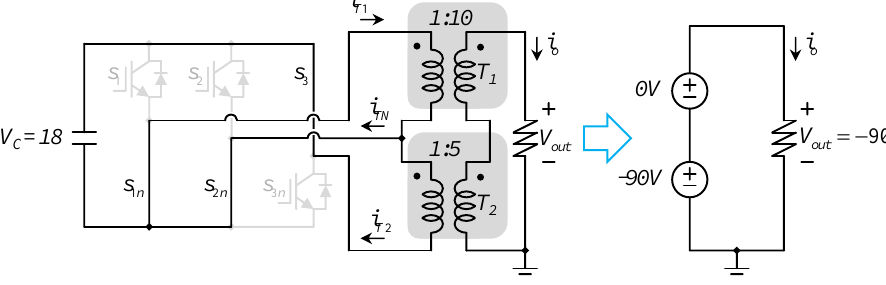
Figure 6. Equivalent circuit when s 1 = 0, s 2 = 0, and s 3 = 1 ( s 1 n = 1, s 2 n = 1, and s 3 n = 0).